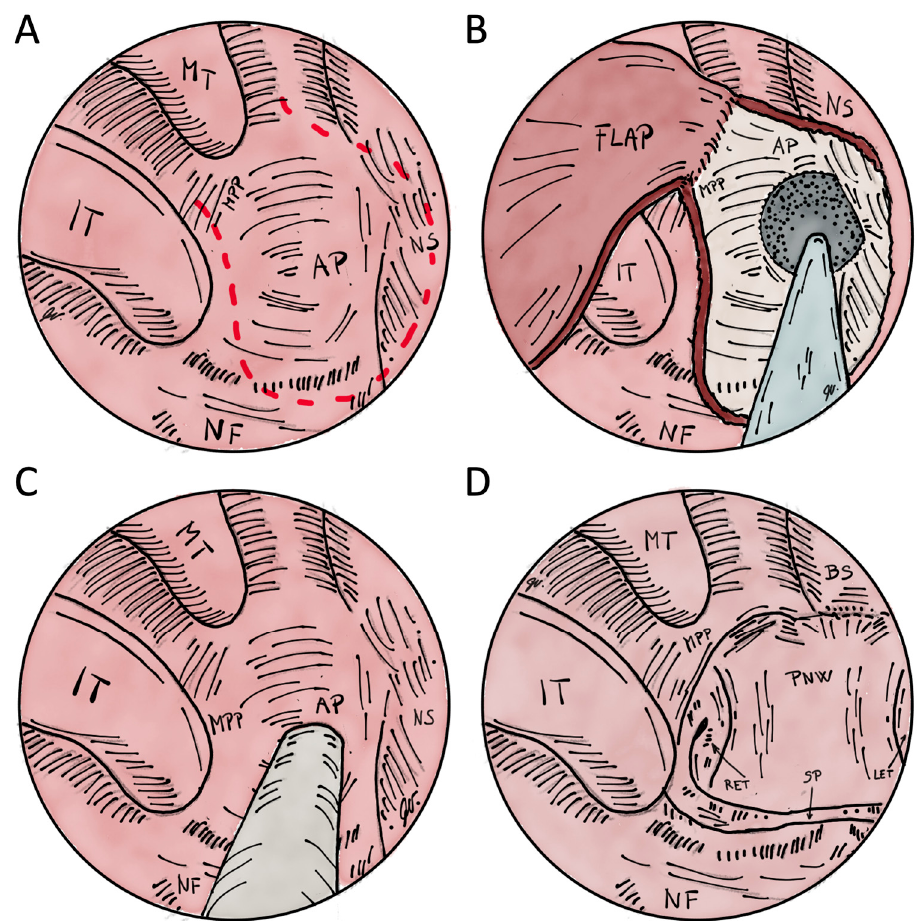
Figure 5. Illustrations of transnasal endoscopic choanoplasty and perforation for the treatment of choanal atresia. ( A )–red dashed line shows flap margins before resection of atretic plate in right nasal cavity. ( B )–flap is elevated to drill the exposed bone of the atretic plate and posterior nasal septum resection. After the resection, the flap is layed on the exposed bone of medial pterygoid plate and base of the sphenoid. ( C )–transnasal perforation technique is shown with or without the assistance of endoscope. There is no mucosal flap elevation. ( D ) after posterior nasal septum resection and drilling of atretic plate to the level of medial pterygoid plate, an unichoana is created. MT–middle turbinate; IT–inferior turbinate; AP–atretic plate; NS–nasal septum; NF–nasal floor; MPP–medial pterygoid plate; BS–base of the sphenoid sinus; RET–right Eustachian tube; LET–left Eustachian tube; PNW–posterior nasopharyngeal wall; SP–soft palate.